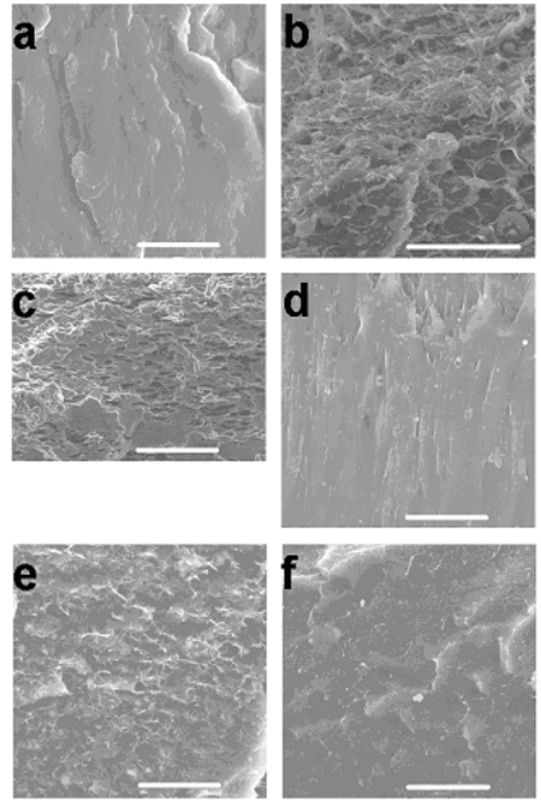
Figure 3. SEM images of the cross-sections of the dry membranes containing the studied fillers: a – no filler, b – ST, c – STM10, d - STM20, e – STV10, f – STV20; white bars correspond to 10 µm.